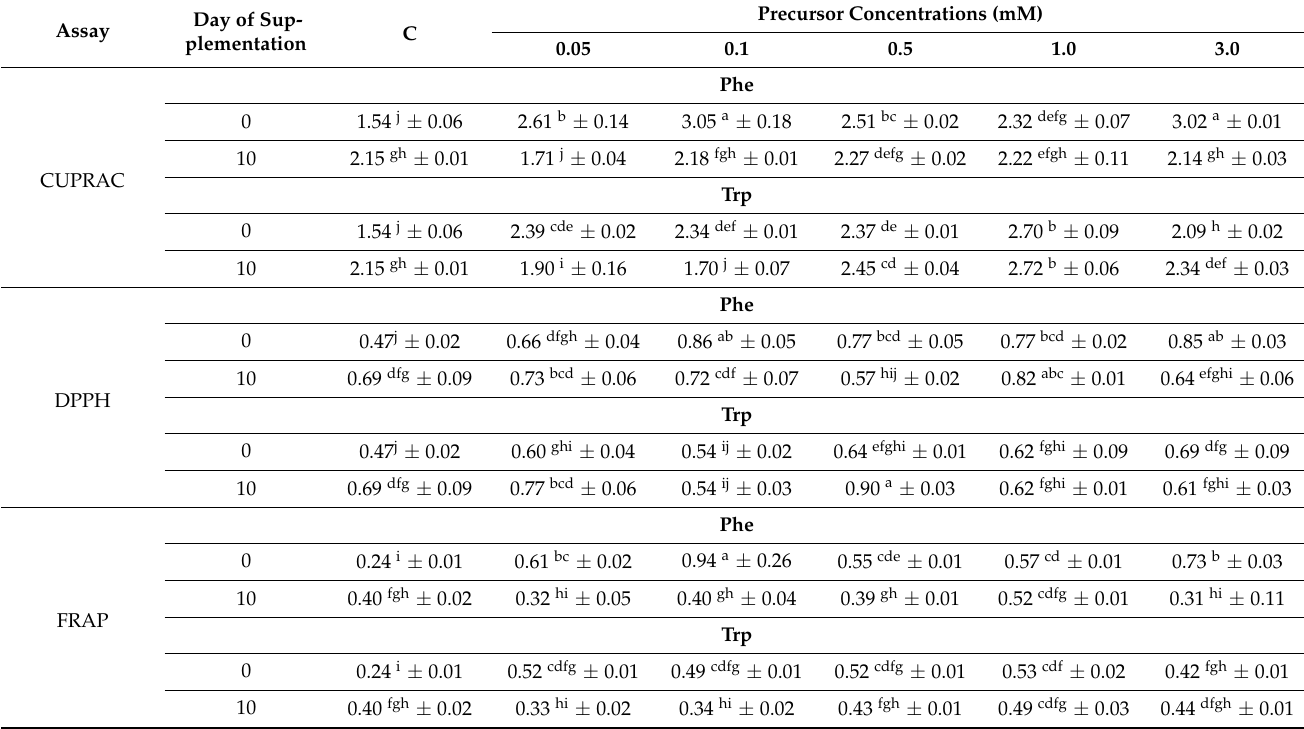
Table 7. Antioxidant activity estimated using the CUPRAC, DPPH, and FRAP assays (mmol TE/100 g DW ± SD) of bioreactor-grown N. officinale microshoot cultures after precursor